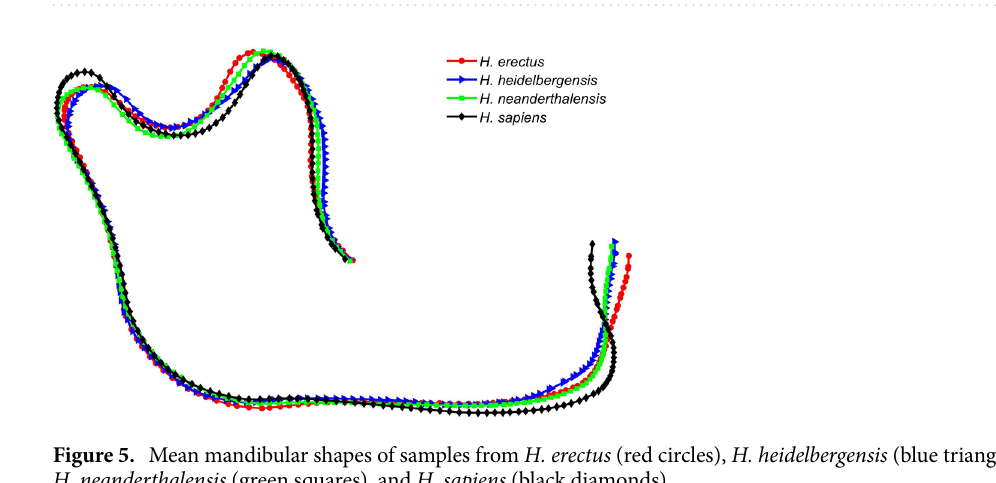
Figure 4. Detecting concave/convex points (shown in red) on a smooth 3D curve using relative angle. Cyan portions are where the relative angle is above T .